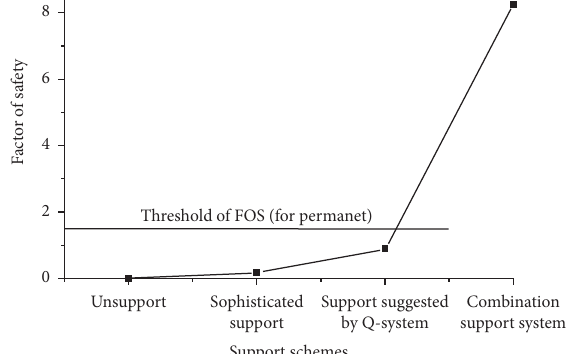
Figure 13. The proposed FOS of the combination support